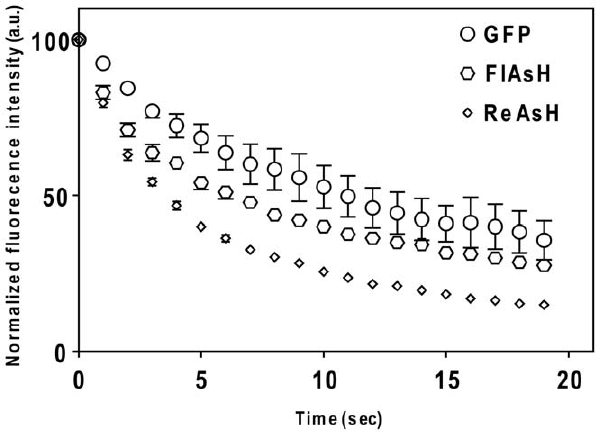
Figure 4. Photobleaching decay curves of GFP from 3D7- KAHRP( + His)-GFP-TC parasites, and ReAsH and FlAsH from 3D7-KAHRP( + His)-TC labeled parasites in Pf- infected erythro- cytes. Continuous exposure of cells for 20 s to the 9.98 mW 475 nm 6 20 nm light (for GFP and FlAsH), or to the 10.88 mW 560 nm 6 22 nm light (for ReAsH) cause fluorescence decays to 65%, 73%, and 85% of the initial emission signals from GFP, FlAsH-, and ReAsH-labeled TC tagged protein,